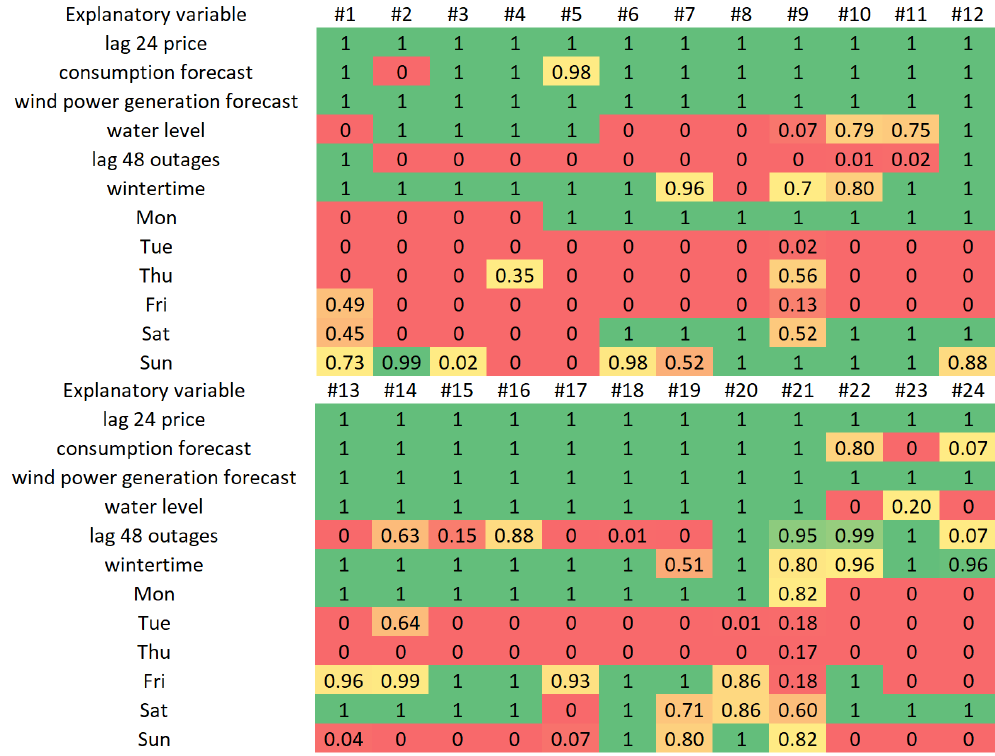
Figure 9. The frequencies with which a variable has a significant influence in the generalised ordered logit models built for hours #1–24 on the basis of extending data windows in the period 29 December 2014–26 March